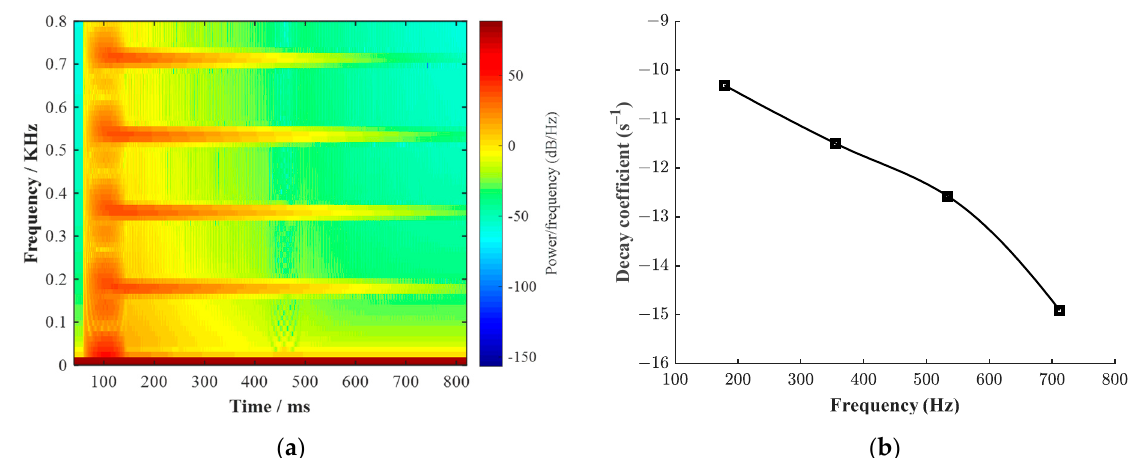
Figure 15. The time-frequency spectrogram and the decay coefficient under different acoustic fre- quencies, computed from the C0 model without cavity. ( a ) The time-frequency spectrogram of the pressure oscillations. ( b ) The decay coefficient under different acoustic frequencies.